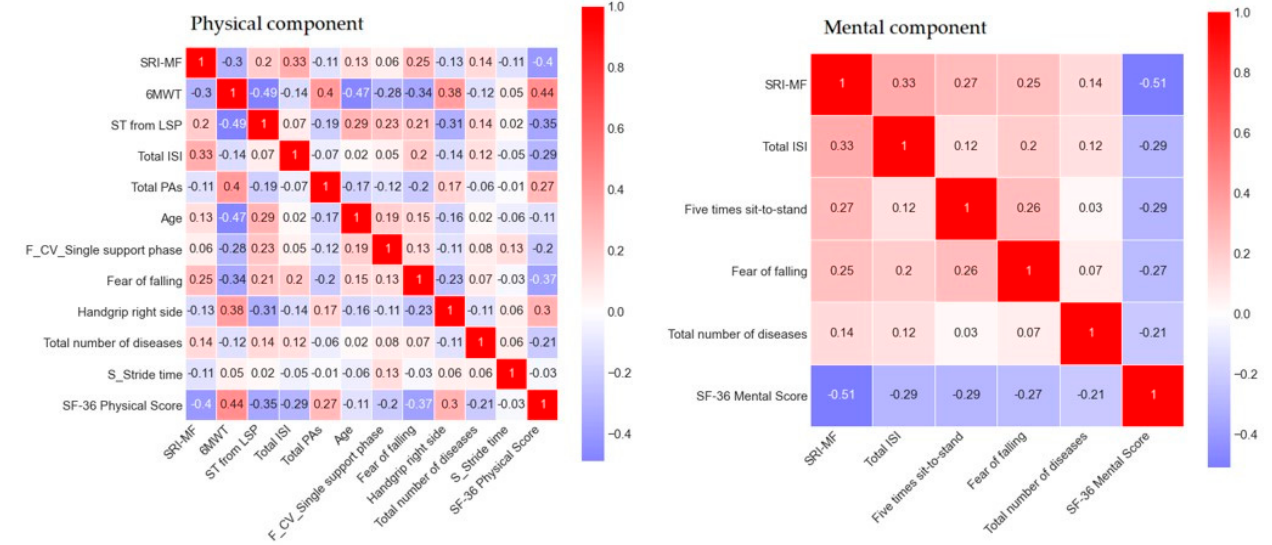
Figure 5. Heat-map of the variables in the best prediction model obtained from the Pearson correlation coefficient matrix, which is illustrated by color based on the correlation level. When the correlation levels are close to +1 and − 1, the colors of the boxes are close to red and blue, respectively.